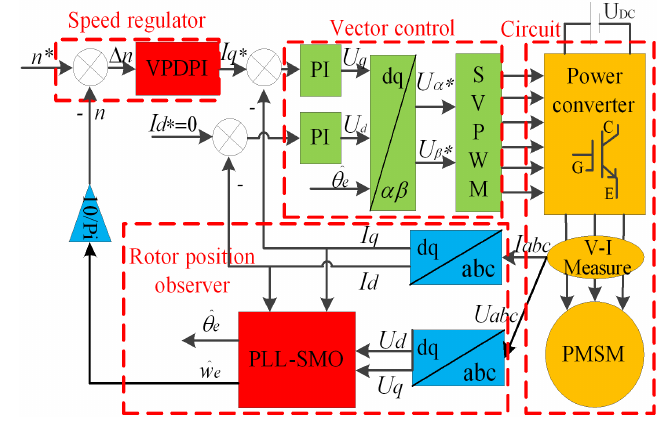
Figure 11. The structure diagram of sensorless PMSM drive